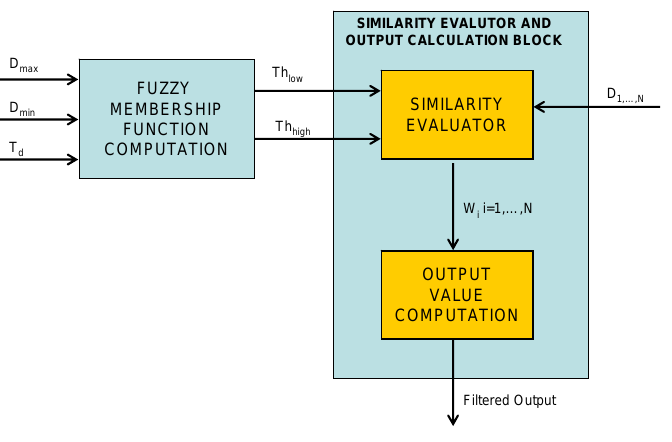
Figure 9. Block diagram of the fuzzy computation process for determining the similarity weights between the central pixel and its N neighborhoods.